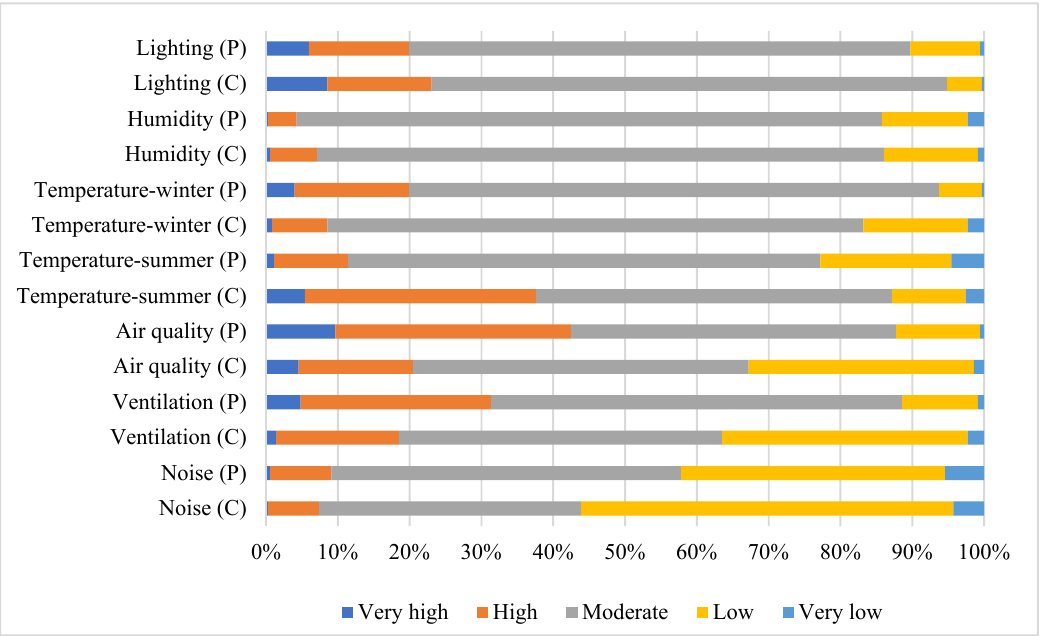
Figure 5. Passengers’ degrees of satisfaction with the various aspects of the sub-ME (Note: C represents the carriage and P represents the platform of the subway).